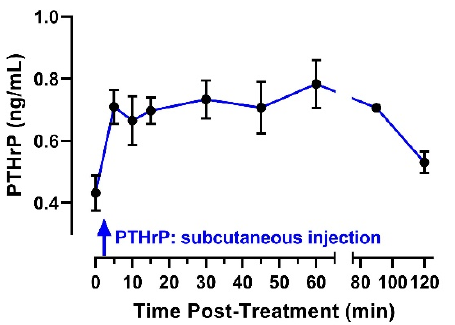
Figure 4. Plasma PTHrP concentration (ng/mL) in anesthetized pigs during the initial 2 h following subcutaneous injection. Data reported as mean ± SEM.